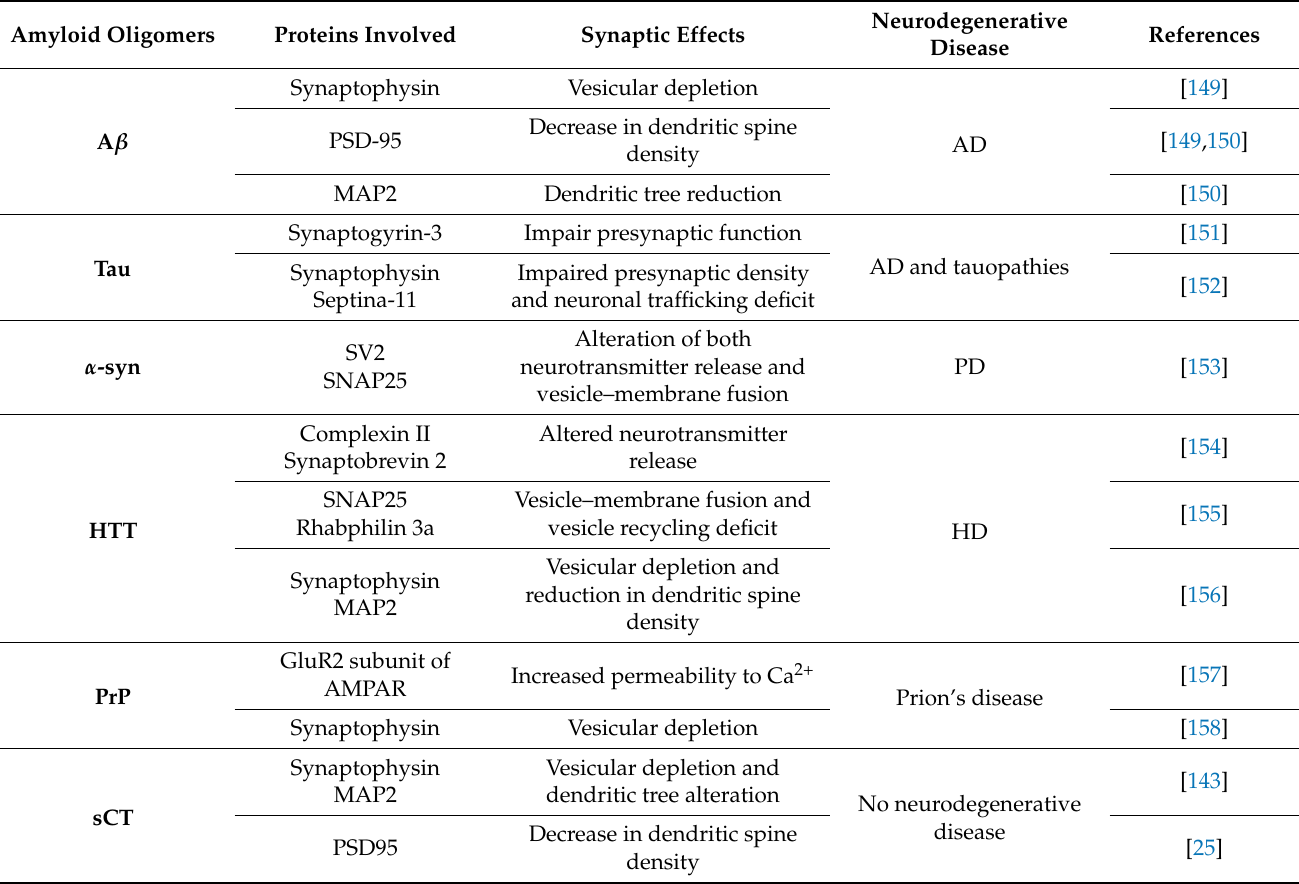
Table 1. Main synaptic proteins affected by the action of amyloid aggregates and the consequent neurodegenerative effects. Amyloid Oligomers Proteins